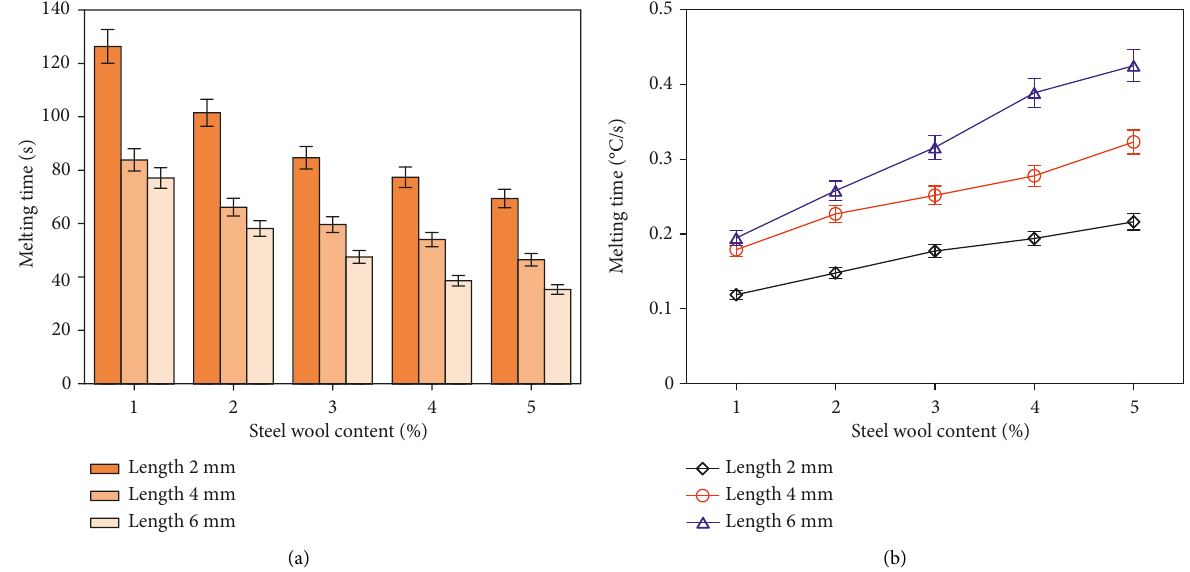
Figure 6: Ice-melting performance with different steel wool content and different lengths.